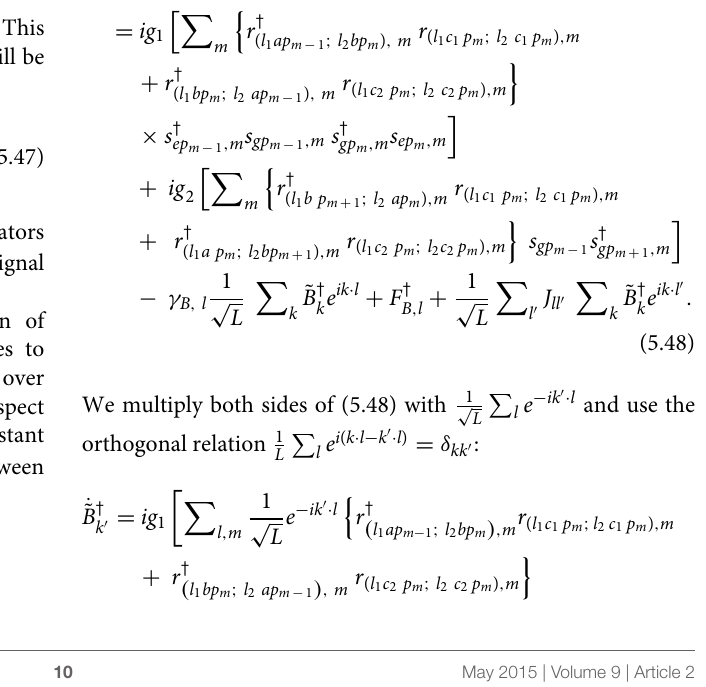
operators are introduced: abp 1 , c 1 p 2 , r † l r † l = = 1 ap 1 ; l 2 bp 2 1 c 1 p 2 ; l 2 c 1 p 2 , c 2 p 3 . The value of the damping bap 3 r † l r † l = = 1 bp 3 ; l 2 ap 2 1 c 2 p 3 ; l 2 c 2 p 3 constant is set to γ g 2 0 . 0005 . The coupling constants are g 1 0 . 1 = = =